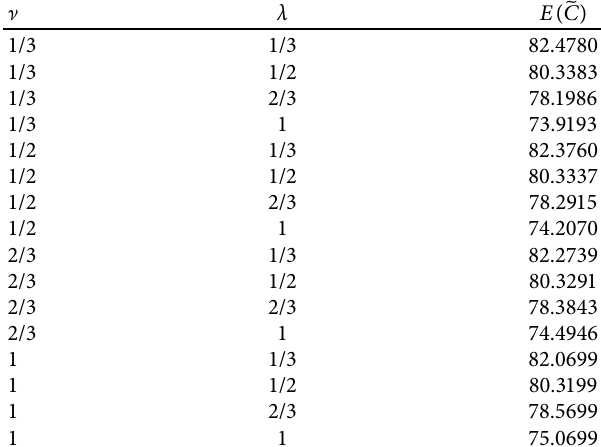
Table 1: The mean value for different subjective